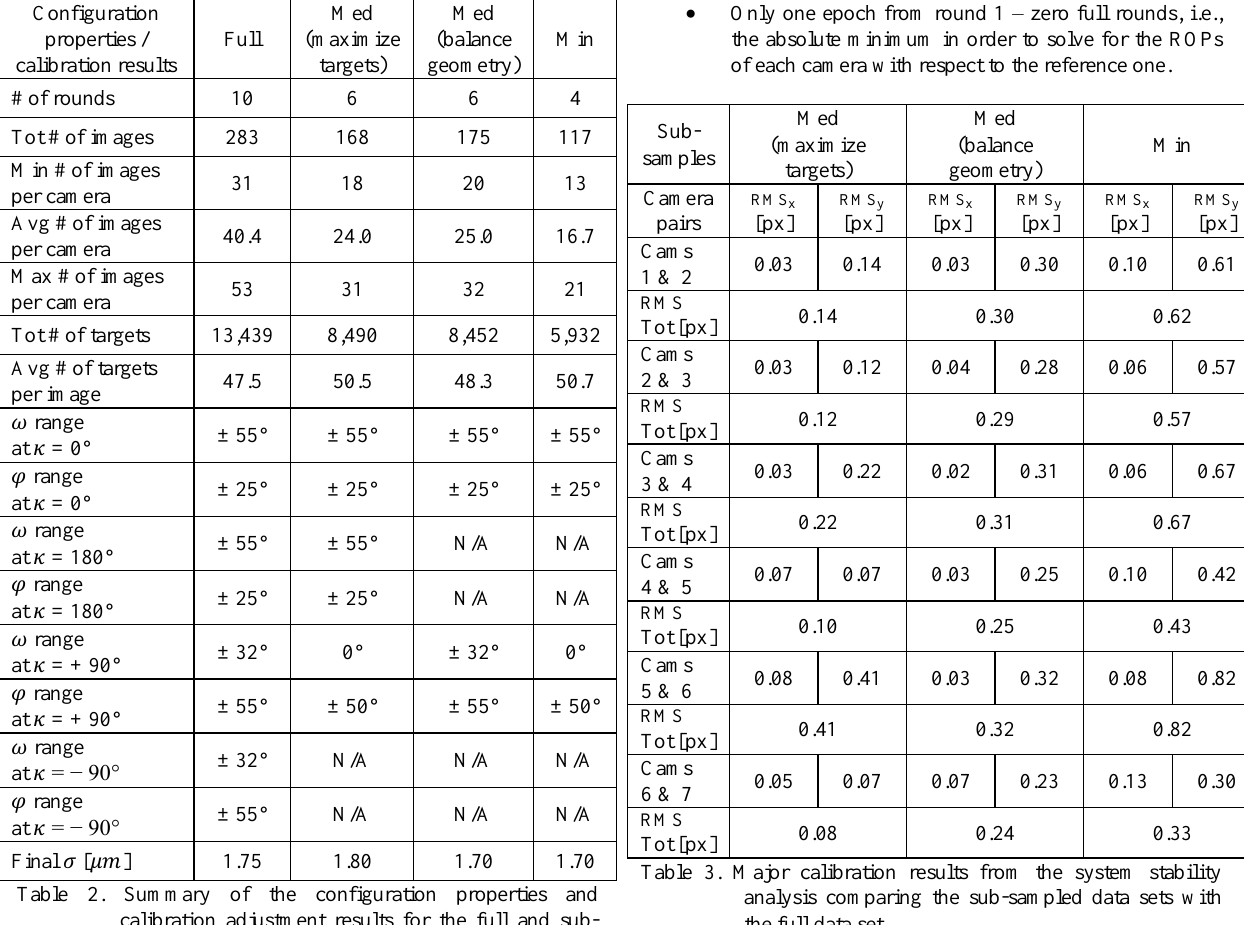
Table 2. Summary of the configuration properties and calibration adjustment results for the full and sub-